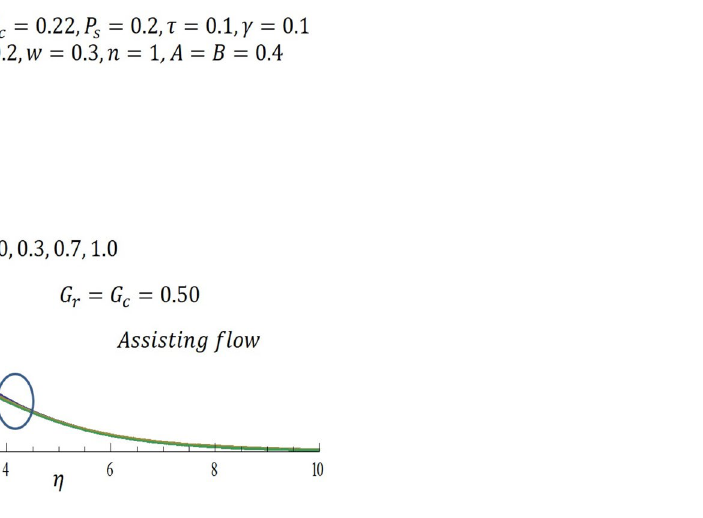
Figure 2. Effect of K on velocity profile when G r = G c =